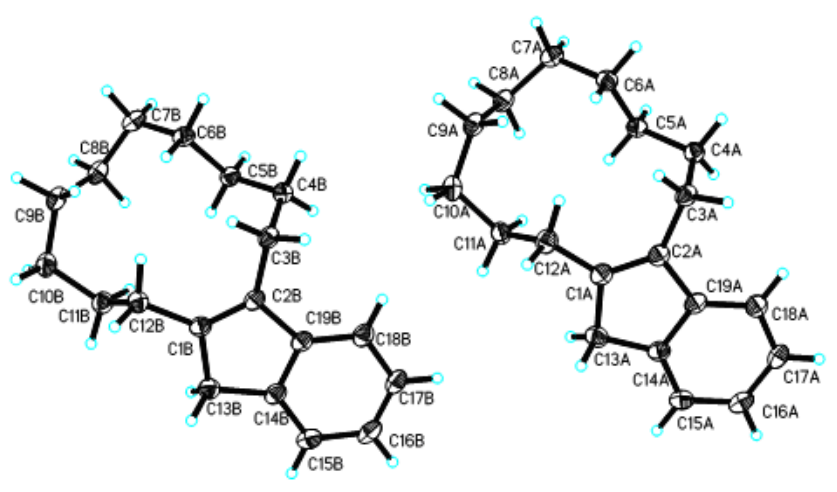
Figure 1. The crystal structure of compound 2A